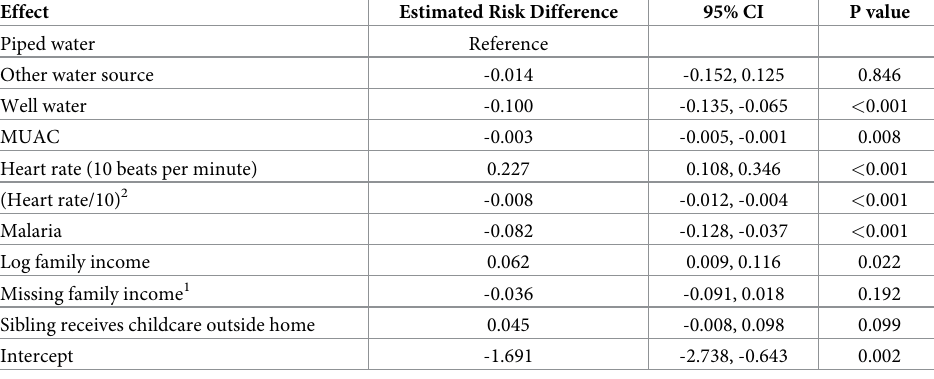
Table 4. Model predicting the risk of treatment failure or relapse among placebo